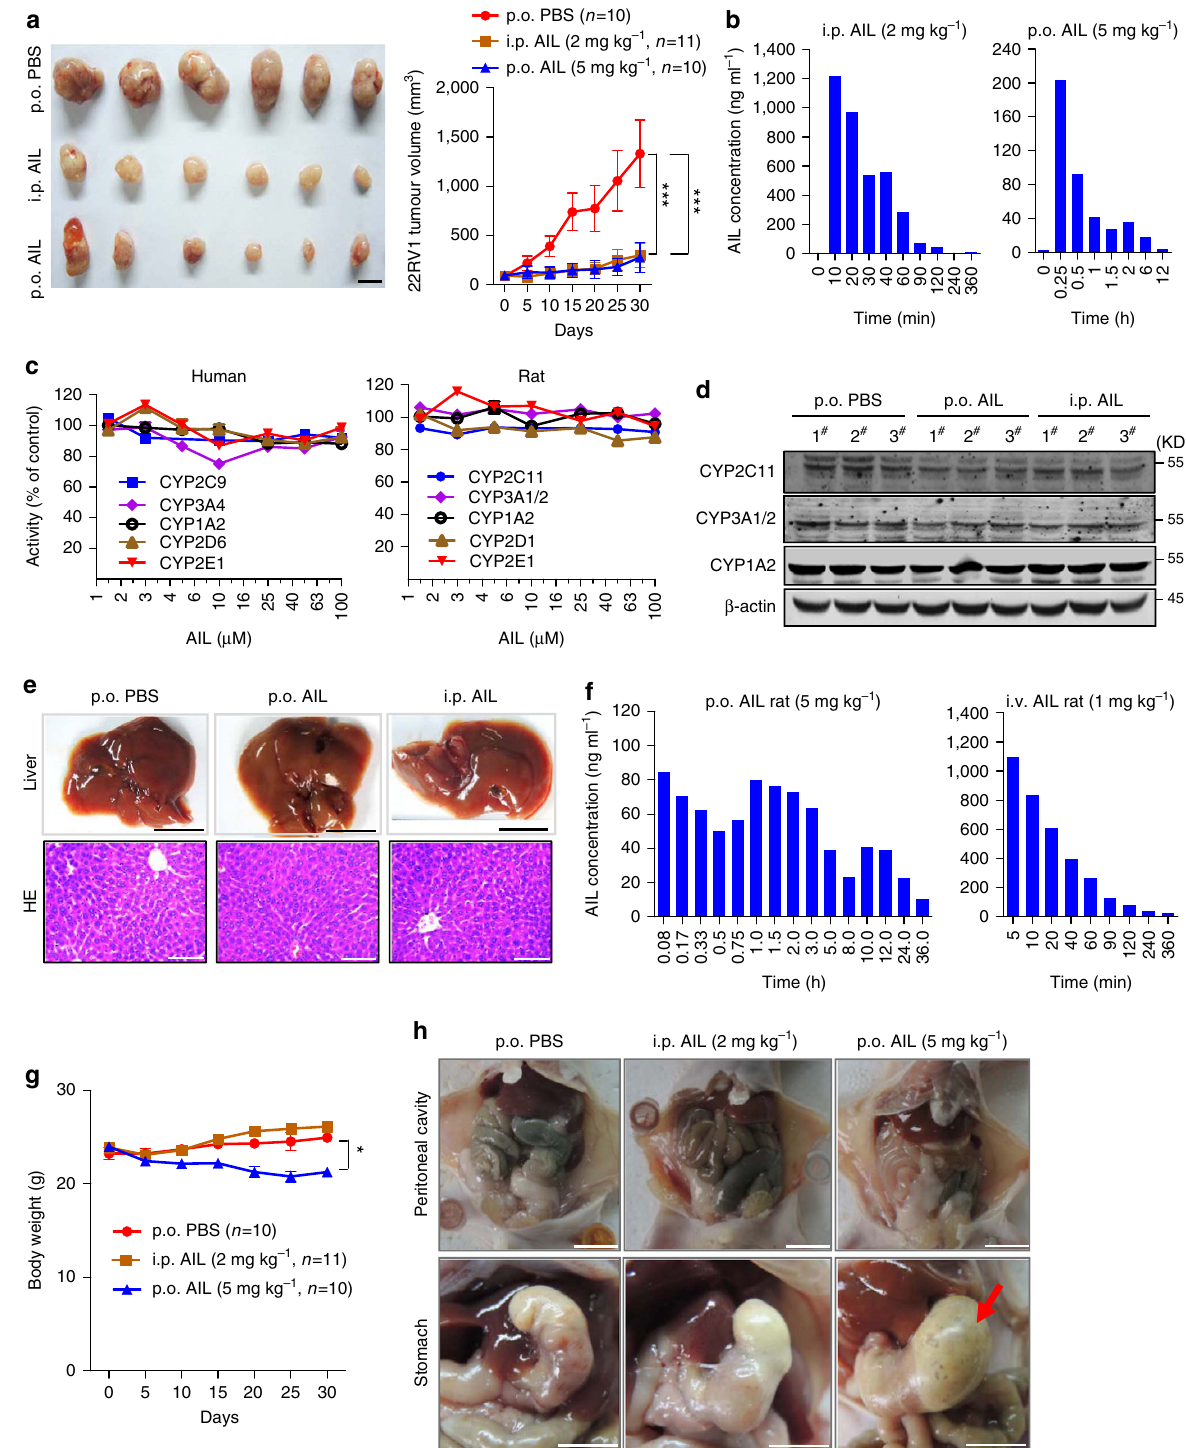
Figure 6 | Pharmacokinetic studies of AIL. ( a ) 22RV1 tumour-bearing mice were treated with p.o. AIL or i.p. AIL and the tumour volumes were measured every 5 days; p.o. PBS served as control. Images show tumours at harvest (30 days after treatment). Scale bar, 1cm. ( b ) The concentration of AIL in plasma was determined by LC-MS/MS following the last drug administration of p.o. AIL or i.p. AIL in tumour-bearing mice. ( c ) Effect of AIL on the activities of rat or human liver cytochrome P450 (CYP) enzymes in vitro . Rat liver microsomes or human liver microsomes were incubated with various concentrations of AIL and the activities of indicated CYP enzymes were measured. ( d , e ) The expression of CYP2C11, CYP3A1 and CYP1A2 in representative livers of the mice treated with p.o. AIL or i.p. AIL or vehicle control was measured by western blotting analysis ( d ) and the livers were photographed and stained with HE ( e ). Scale bars: the black scale bar is 1cm (top) and the white scale bar is 50 m m (bottom). ( f ) The concentration of AIL in rat plasma was determined by LC-MS/MS after administration of p.o. AIL or i.v. AIL. ( g ) 22RV1 tumour-bearing mice were treated with p.o. AIL or i.p. AIL and mouse body weight was measured every 5 days. ( h ) Intestines and stomachs of the mice were dissected and images were taken at the end of AIL administration. Scale bar, 1cm. Data represent the mean ± s.d.; * P o 0.05, ** P o 0.01, *** P o 0.001 by one-way ANOVA followed by Bonferroni multiple comparison